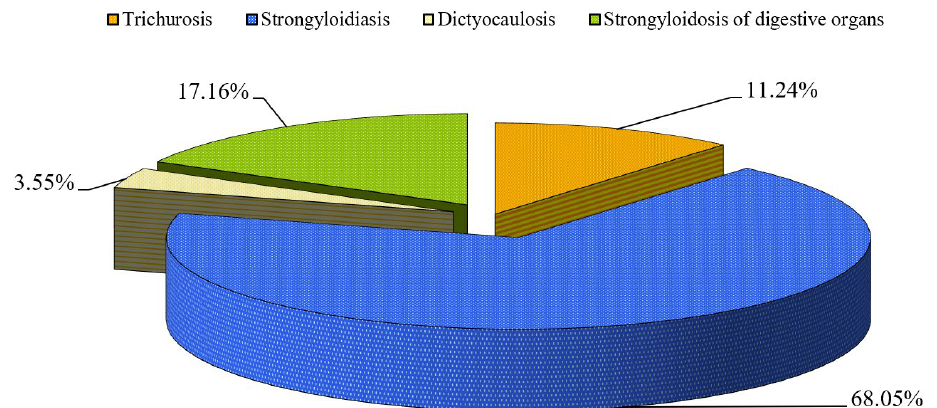
Fig. 5. The ratio of detected nematodes in sheep in the Poltava